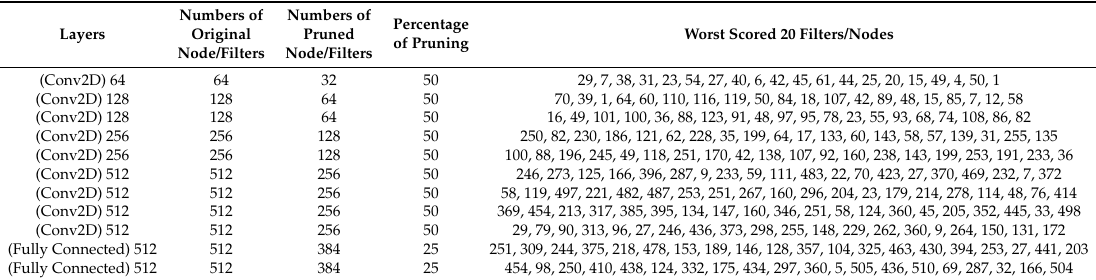
Table 4. Node pruning details in each layer. The worst scored nodes can be used in future references as a